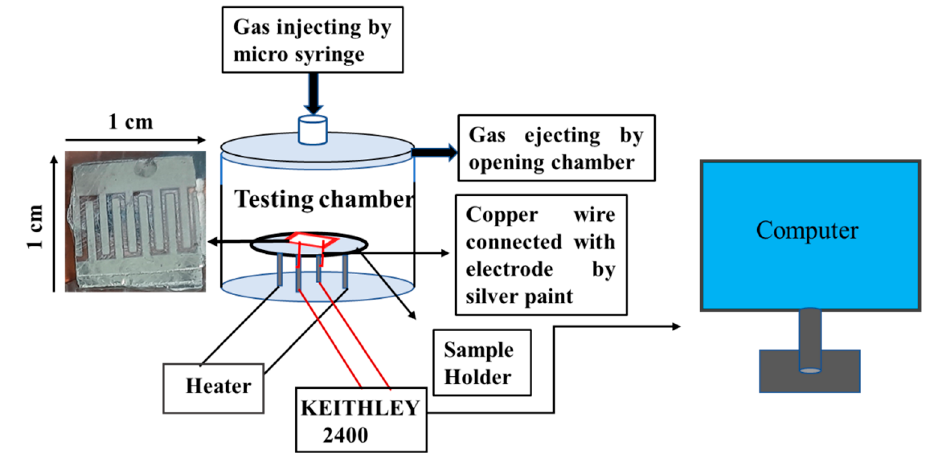
Figure 6. Schematic diagram of gas monitoring set up with the fabricated